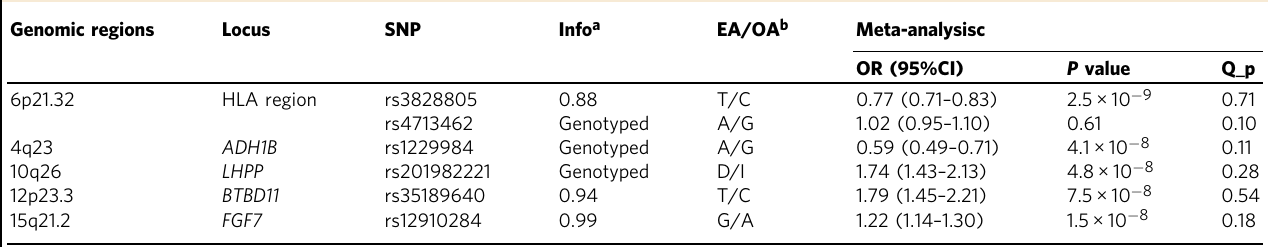
Table 4 Top genome-wide signi fi cant regions and the highlighted ones in previous analysis from regional meta-analyses of OCC and HPV(-)OPC pooled